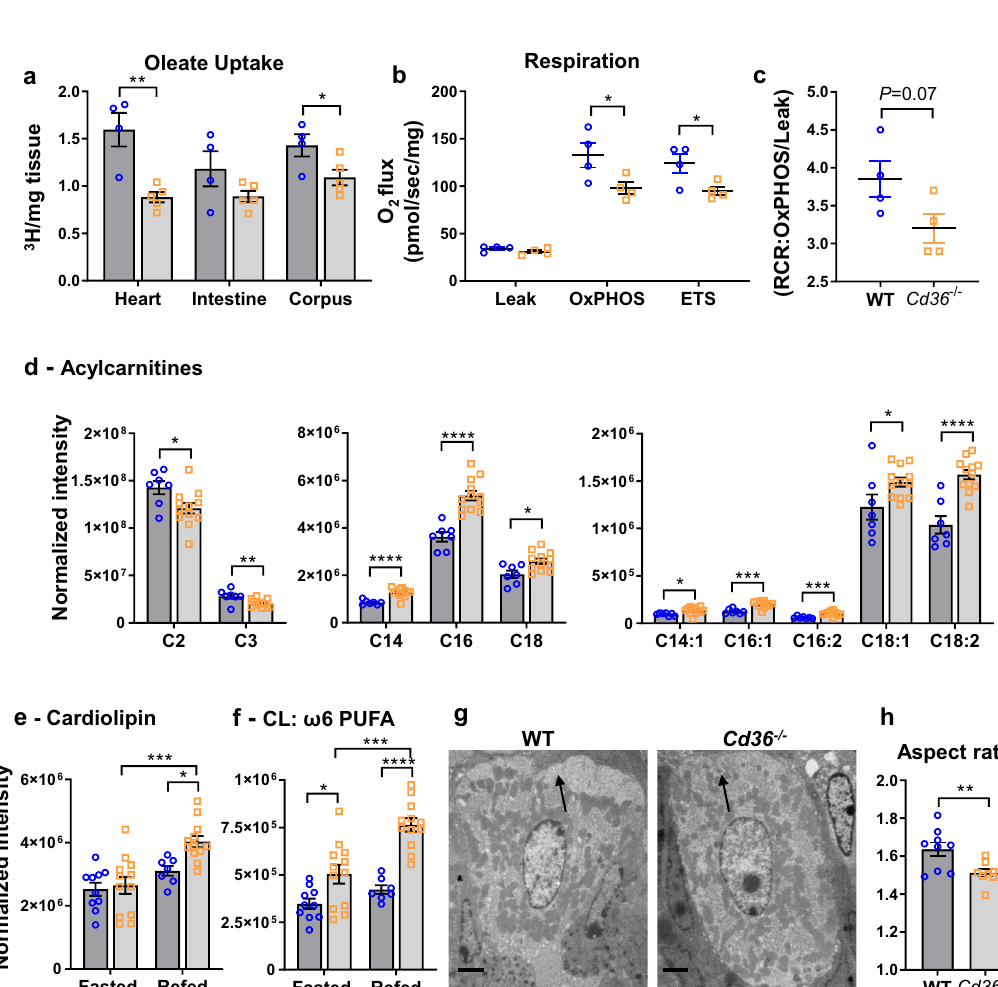
Fig. 5 Decreased tissue FA uptake and respiration by Cd36 − / − stomachs. a Tissue uptake of oleic acid in wildtype (WT) and Cd36 − / − mice. Four-month- old mice 16 h fasted mice, were given a retro-orbital injection of [ 3 H]oleic acid and tissues collected 5 min later for measuring radioactivity. b High- resolution respirometry (Oxygraph-2k) of permeabilized corpus mucosa from WT and Cd36 − / − mice. Leak: plus malate (1 mM), glutamate (10 mM) and pyruvate (5 mM). OxPHOS: Oxygen consumption, plus ADP (5 mM) and succinate (10 mM). ETS: Maximum fl ux after FCCP uncoupling. c Ratio of OxPHOS/leak in WT and Cd36 − / − mucosa showing trend for lower coupling ef fi ciency. d Cd36 − / − stomachs have lower levels of short-chain acylcarnitines but accumulate long-chain acylcarnitines. e, f cardiolipin (CL) enrichment with ω 6 PUFA. g transmission electron microscopy (TEM) showing altered morphology of PC mitochondria (arrow) in Cd36 − / − mice, scale bar: 2 µ m. h Mitochondrial circularity and aspect ratio (major/minor axis). Signi fi cance was calculated using a two-sided unpaired t test or a two-way ANOVA followed by post hoc tests by Sidak multiple comparisons ( e , f , and h ). * P < 0.05, * P < 0.01, *** P < 0.001, **** P < 0.0001. Data are means + SEM. a n = 4 – 5; b – c n = 4; d – f n = 7 – 12; h n = 600 mitochondria from 9 PCs/ However, unlike the Cd36 − / − mice which survived the TAM protocol, the EC- Cd36 − / − mice in two separate experiments died during the recovery phase. The reason for the mortality is unclear and suggests unresolved in fl ammation from the combination of gastric damage after TAM with damage from Cd36 deletion in endothelial cells.